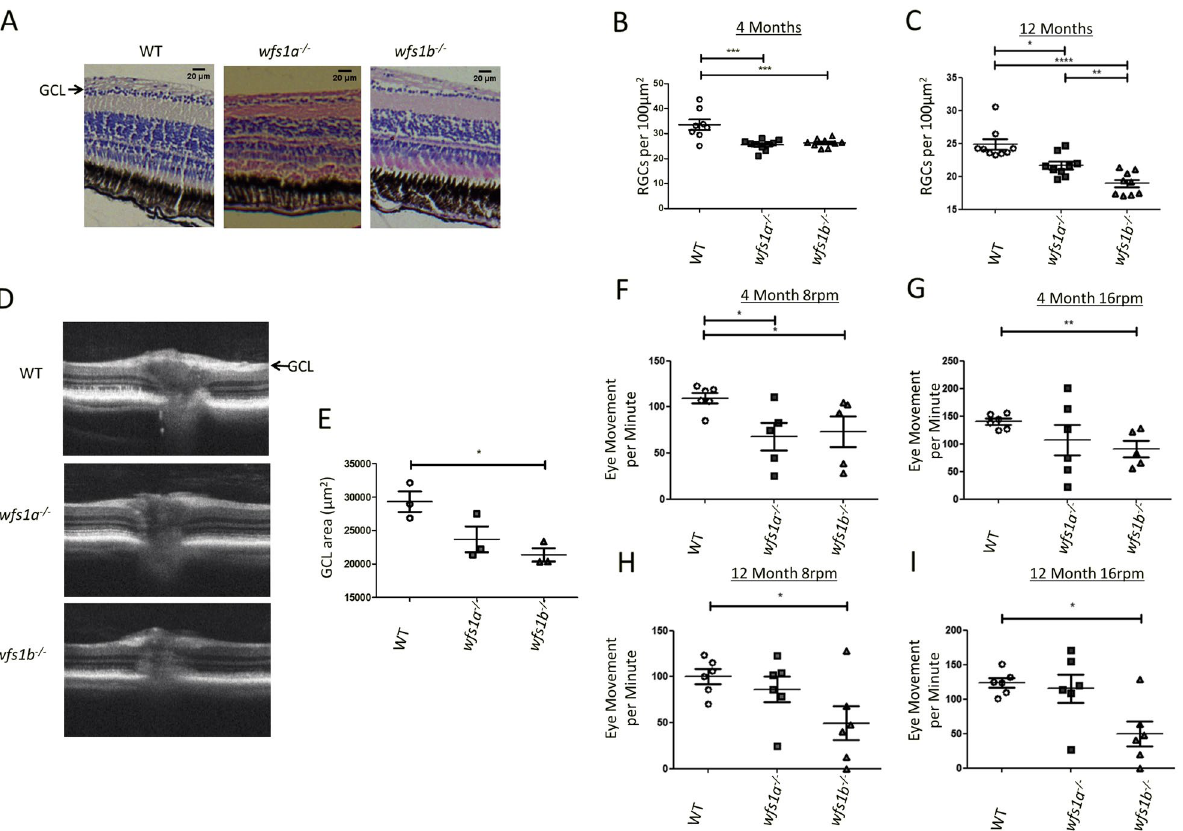
Figure 4. Retinal ganglion cell count and visual function in wfs1a −/− and wfs1b −/− zebrafish. ( A ) Representative images of WT, wfs1a −/− and wfs1b −/− retinal sections at 4 months of age (scale bar = 20 µm). For RGC counts, 6 boxes of the same area (100 μm 2 ) were used with 3 boxes on either side of the optic nerve. The number of RGC cell bodies were counted and averaged. ( B ) RGC count per 100 μm 2 at 4 months of age (WT n = 8; wfs1a −/− n = 10; wfs1b −/− n = 9). ( C ) RGC count per 100 μm 2 at 12 months of age (WT n = 10; wfs1a −/− n = 9; wfs1b −/− n = 9). Data plots represent mean ± SEM. Statistical significance was calculated using the Kruskal–Wallis test (One-way ANOVA on ranks). ( D ) Optical coherence tomography (OCT) images of retinal cross-sections from 12-month-old zebrafish showing significant thinning of the ganglion cell layer (GCL) in wfs1a −/− and wfs1b −/− zebrafish (arrow). ( E ) Measurement of GCL area (WT mean = 29,393 ± 2653 μm 2 ; wfs1a −/− mean = 23,688 ± 3332 μm 2 ; wfs1b −/− mean = 21,363 ± 1,737 μm 2 ; n = 3 for all 3 groups). Data plots represent mean ± SEM. Statistical significance was calculated using One-way ANOVA with Bonferroni’s multiple comparison tests. ( F–I ) Optokinetic response (OKR) of 4- and 12-month-old fish tested at 8 rpm and 16 rpm. Videos were recorded of fish eye tracking and the movements were manually counted (Supplementary video 3). Data plots represent mean ± SEM. Statistical significance was calculated using One-way ANOVA with Bonferroni’s multiple comparison tests. *p < 0.05; **p < 0.01; ***p < 0.005; ****p < 0.001; rpm: revolutions per Zebrafish maintenance. All zebrafish procedures were performed under Home Office UK licence regula- tions and approved by the Newcastle University Animal Welfare and Ethical Review Board. Fish strains used in this study include AB, sa10021 ( wfs1a ) and sa16422 ( wfs1b ). Embryos were collected from breeding pairs of zebrafish and grown for up to 5 days in E3 medium (5 mM NaCl, 0.17 mM KCl, 10 mM HEPES, 0.33 mM MgSO 4 , 0.33 mM CaCl 2 0.00002% methylene blue) placed in an incubator at 27.5 °C. Zebrafish strains. Two heterozygote mutant lines were purchased from the European Zebrafish Resource Centre (EZRC). The wfs1a (wfs1a sa10021 41 ) line had a G > A nonsense mutation at amino acid (aa) 692 resulting in a TAG stop codon (Fig. S3). The wfs1 b ( wfs1b sa16422 41 ) line had a G > A nonsense mutation at aa 493 resulting in a TGA stop codon. The F2 lines obtained from the EZRC were outcrossed twice prior to experimental work. The lines were inbred to create two homozygous lines, wfs1a −/− and wfs1 b −/− (Fig. S2). This was confirmed by Sanger sequencing of isolated genomic DNA (Fig. S2A,B). Unless stated, experimental crosses were performed with homozygous knockouts to remove the confounding factor of maternal RNA. Zebrafish were group mated with 3 males and 3 females per large breeding tank. Double knockout mutants were also derived (Fig. S2C). Experi- mental blinding was not performed. However, prior to analysis, data was blinded to minimise potential bias. AB control lines were used in all experiments (https:// zfin. org/ action/ genot ype/ view/ ZDB- GENO- 960809-7).